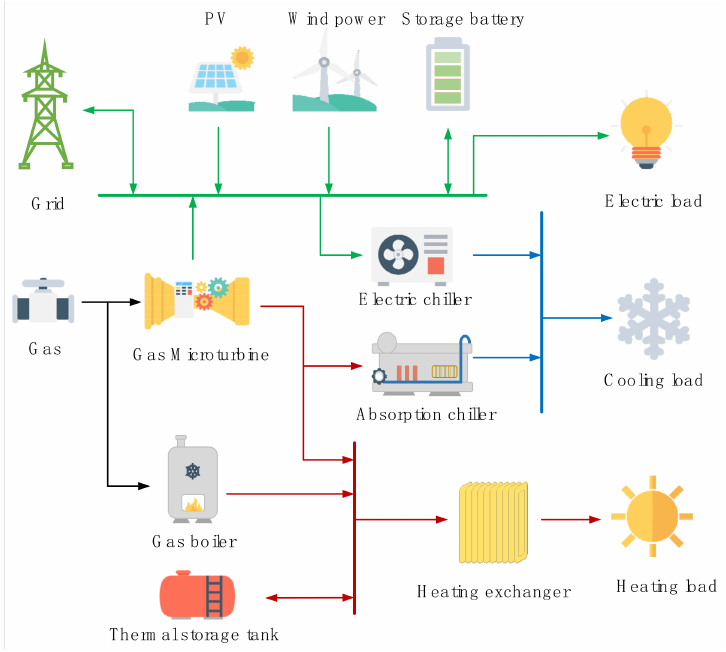
Figure 1. The diagram of integrated energy